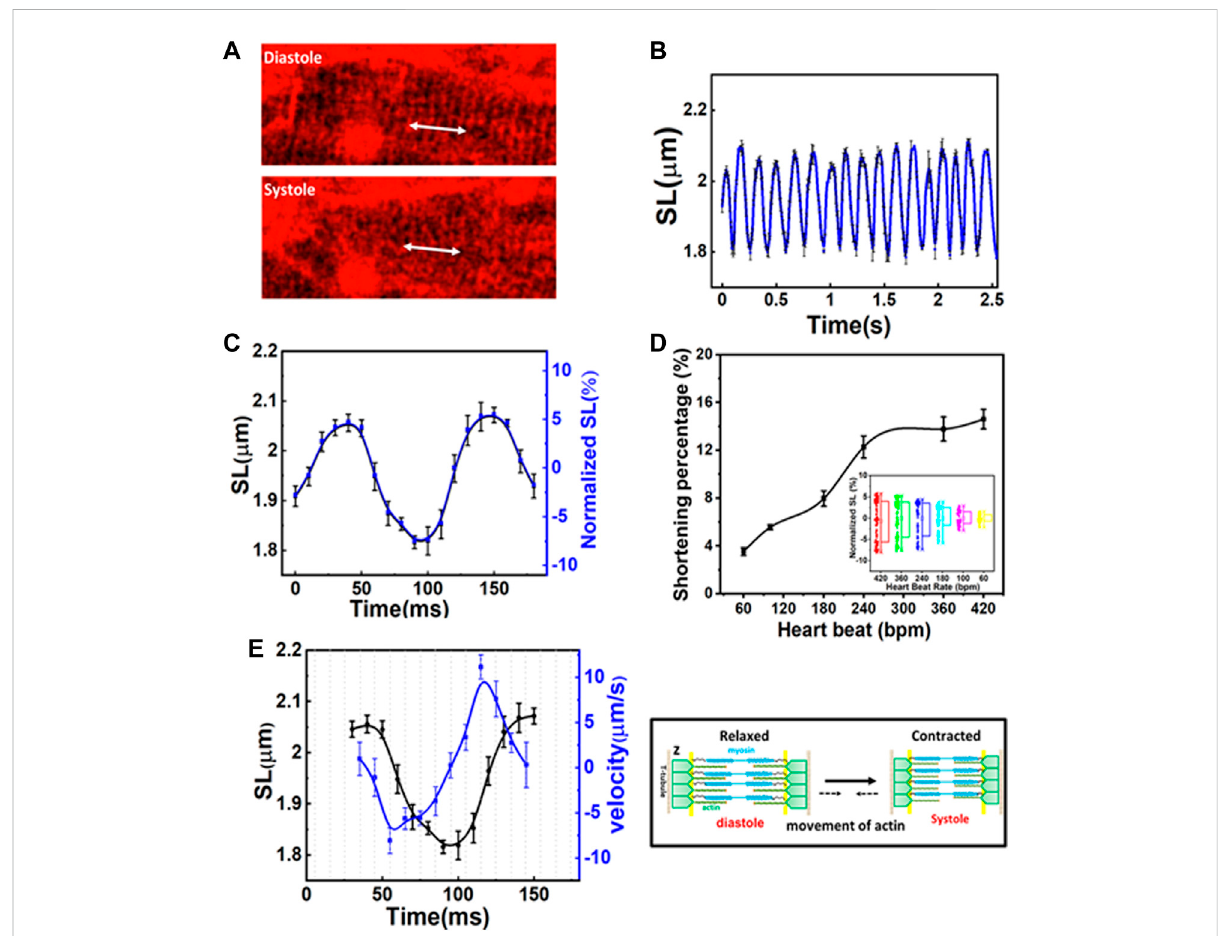
FIGURE 2 (A) Two-photonimagesofthesamecardiomyocyteatadifferentphaseofthecontractioncycle. (B) Variationinsarcomerelength(SL)overtime in several contraction cycles. (C) The original and normalized SLs at different phases in the contraction cycle. The SLs are measured at a given phase (at a delay time with respect to R-wave) in a contraction cycle and averaged over several contraction cycles. (D) The shortening percentage (% Δ SL) and normalized SL variations were measured at different heartbeat rates. (E) The correlation between SL (left Y axis) and shortening velocity (right Y axis) inone cardiac cycle( N = 3,mean ± standard deviation). A positive velocity represents sarcomere lengthening whereas negative velocity indicates sarcomere